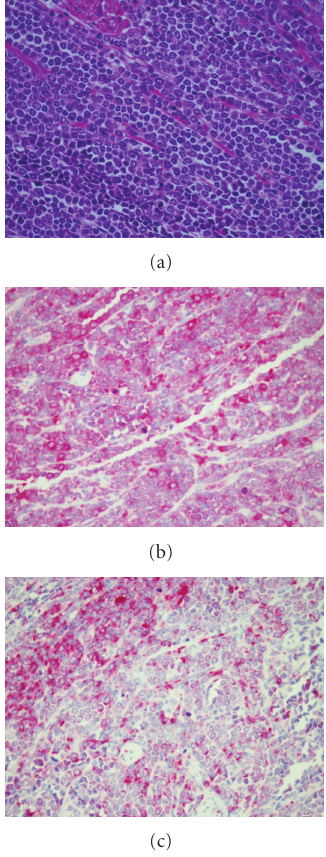
Figure 1: Immunohistology of granulocytic sarcoma. Tumor formation by monomorphic blast cells ((a), HE-stain). Significant proportions of the blast cells were positive for myeloperoxidase (b) and the monocyte marker CD68